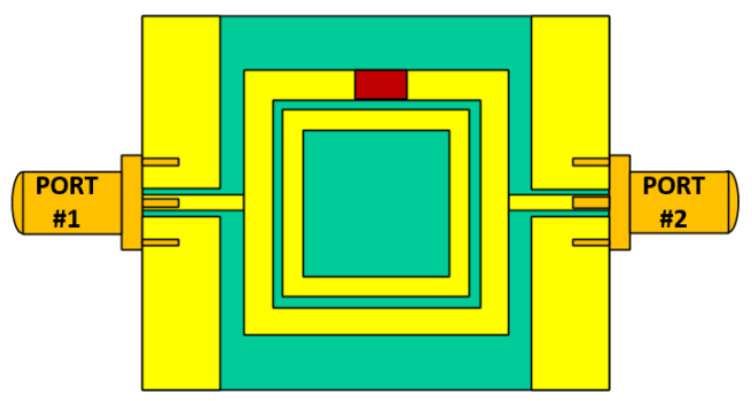
Figure 22. Picture of the Fabricated humidity sensor.